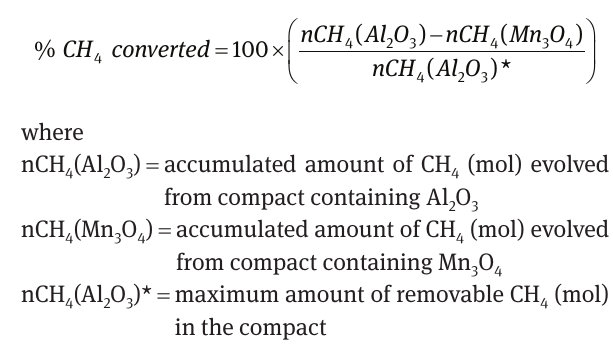
After 60 s of heating the compact, the area ratio H / 2 CH was approximately 1.0 but this gradually increased to 4 about 2.5 after 150 s, indicating that CH undergoes crack- 4 ing to generate more H and nascent C in the course of 2 heating, probably through Eq. 2a.